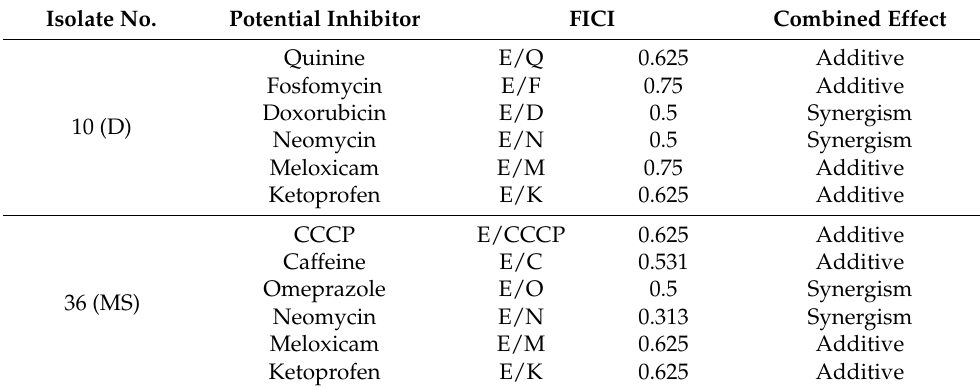
Isolate no.: number of isolate, FICI: fractional inhibitory concentration index, E: erythromycin, D: doxorubicin, N: neomycin, M: meloxicam, CCCP: carbonyl cyanide m-chlorophenylhydrazine, C: caffeine, O: omeprazole, K: ketoprofen.